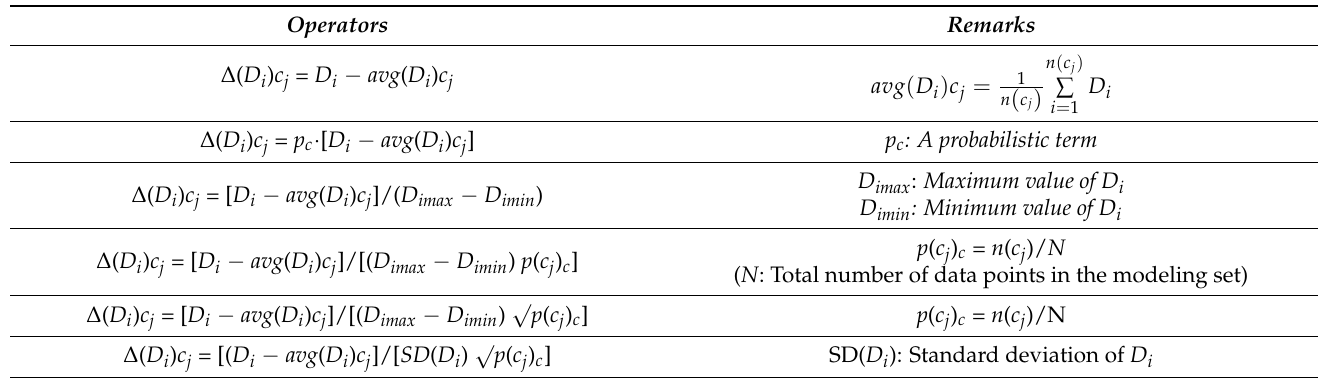
Table 1. Box–Jenkins operators used in the different studies